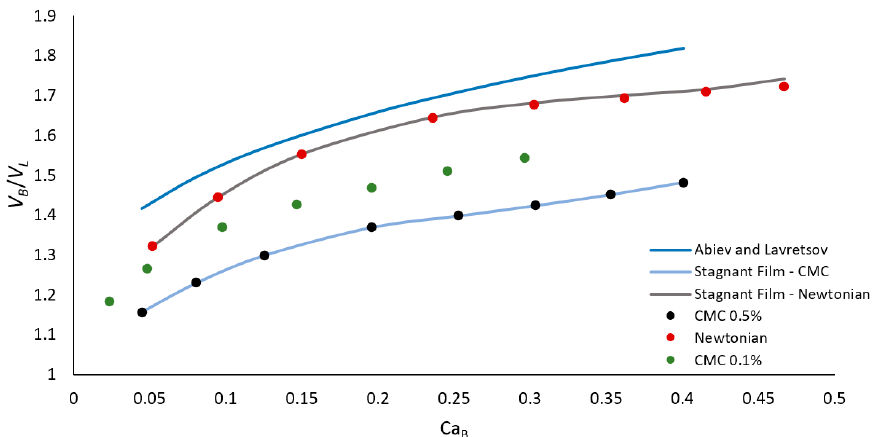
Figure 6. Bubble velocity normalized by the liquid velocity as a function of the bubble capillary number. The numerical results are for bubbles flowing in CMC solutions (0.1% and 0.5%) and in a Newtonian liquid with a viscosity corresponding to the characteristic shear rate. The theoretical predictions are based on the stagnant film model and on the Abiev and Lavretsov [38] correlation. The numerical data concerns the systems with a channel of D = 100 μ m.